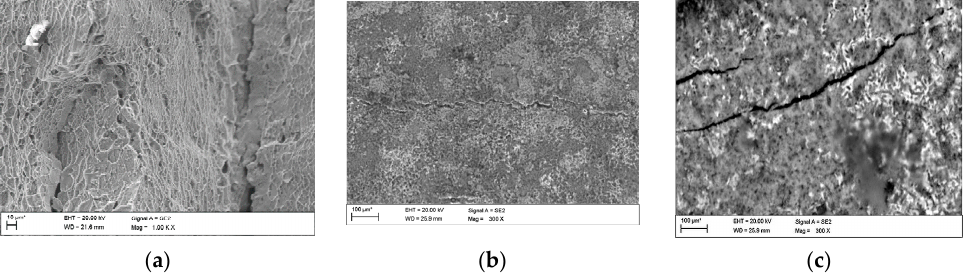
Figure 7. Microscopic images of crack origin, sample from a series subjected to the solution in tap water: ( a ) sample in Figure 5a, ( b ) sample in Figure 5b, ( c ) sample in Figure 5c.